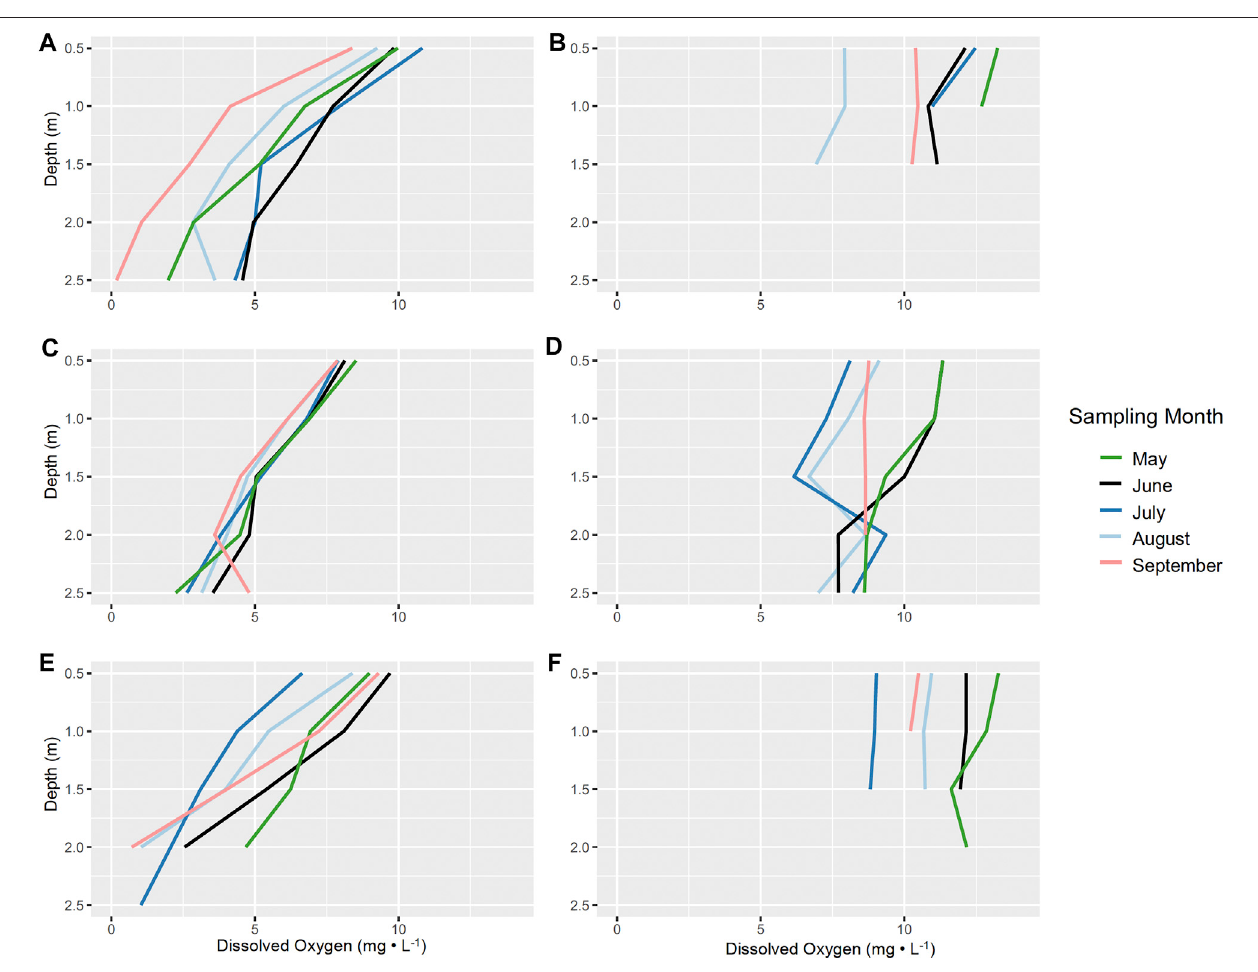
FIGURE2| Averageddissolvedoxygenpro fi les(mgL − 1 )forsiteswithandwithout N.obtusa presencepermonth andyear. (A) .2017dissolvedoxygenpro fi les for sites with N. obtusa , (B) . 2017 dissolved oxygen pro fi les for sites without N. obtusa , (C) . 2018 dissolved oxygen pro fi les for sites with N. obtusa , (D) . 2018 dissolved oxygen pro fi les for sites without N. obtusa , (E) 2019 dissolved oxygen pro fi les for sites with N. obtusa , (F) . 2019 dissolved oxygen pro fi les for sites without N. obtusa .